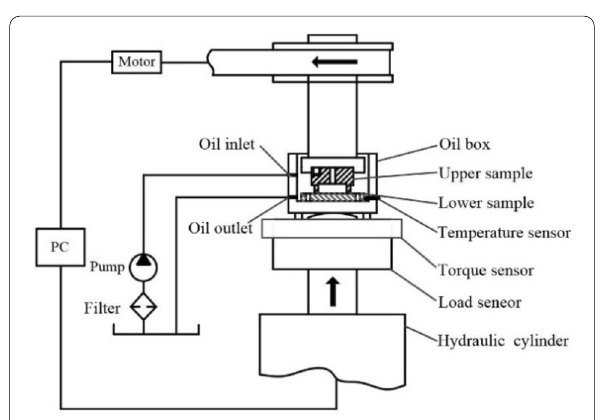
Figure 6 Sketch of the ring-on-disk tribometer